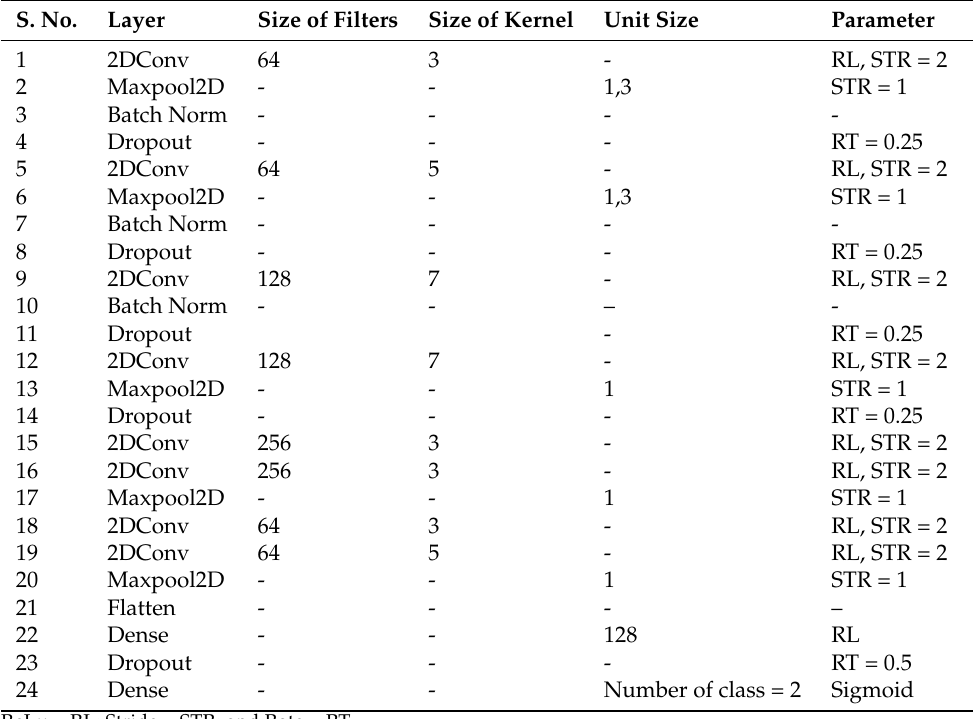
Table 2. The layers employed in the proposed 2D-CNN model.